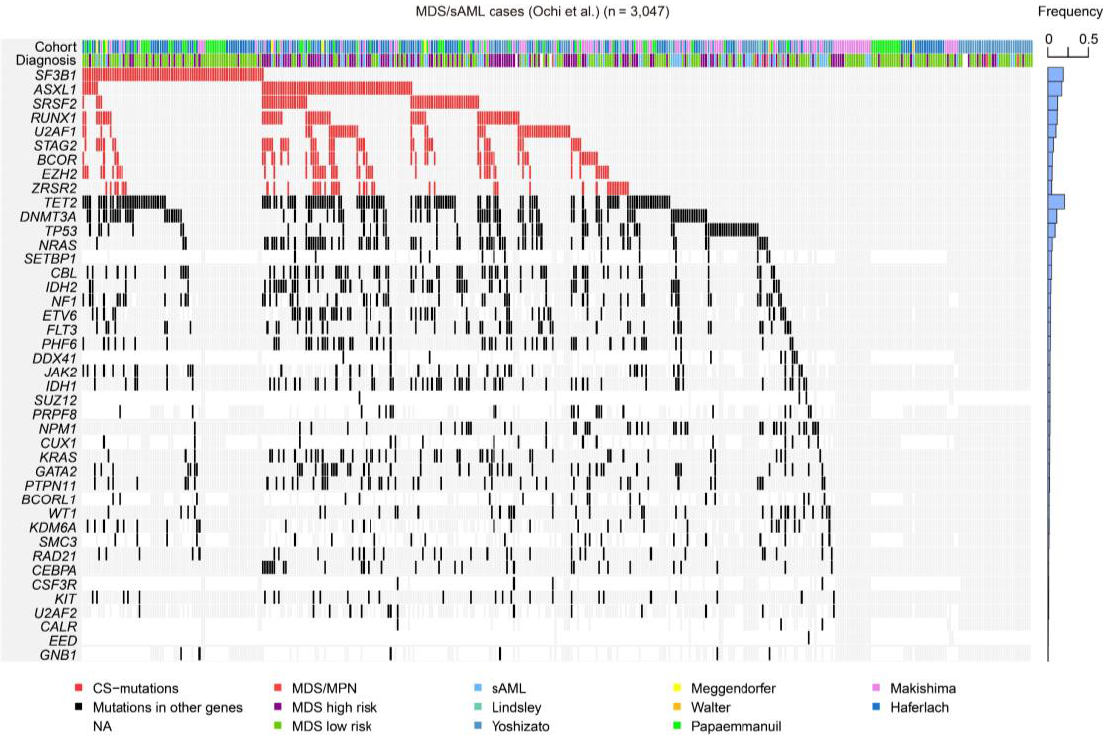
Figure 5. CS-mutations in MDS/sAML. A heatmap representing the mutations found in a large cohort of MDS, related myeloid disorders, and sAML, as shown in our previous study [22]. Blue bars on the right show frequencies of mutations in all cases. MPN, myeloproliferative neoplasm; NA, not available.